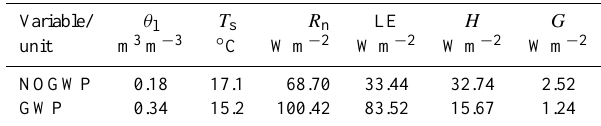
Table 1. The texture composition and the physical properties of the soils used in the SHAW simulations. Property Unit Sand Loam